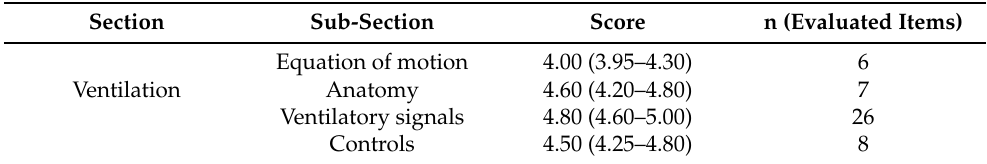
Table 5. Delphi validation results of the “Anatomy and Physiology” module, organized by sections and sub-sections and scored from 1 to 5.